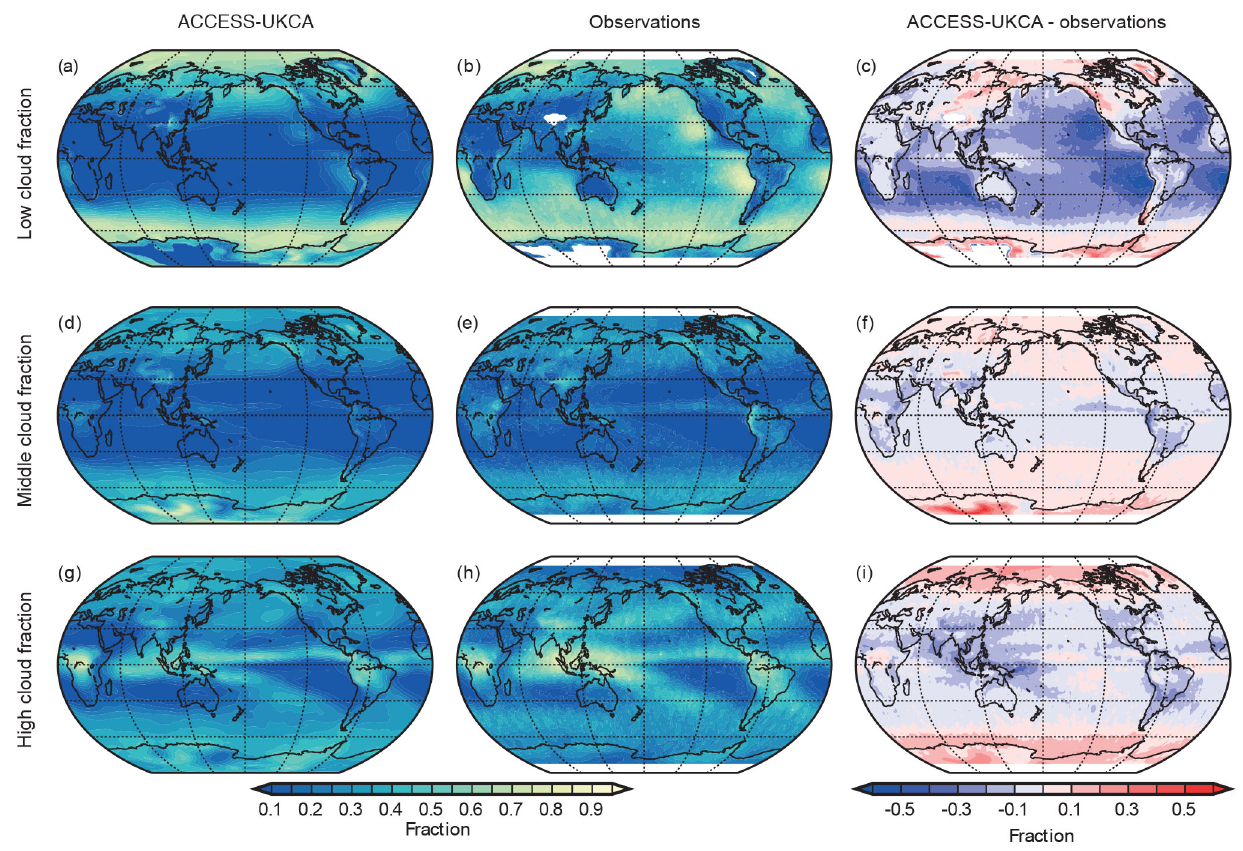
Figure 3. The 2006–2009 annual mean of the ACCESS-UKCA Ctl (a, d, g) compared to the CALIPSO-GOCCP (Chepfer et al., 2010) climatology (b, e, h) , with the relative differences between the two shown in (c) , (f) and (i) (model – observations). Panels (a) , (b) and (c) show the low cloud fraction, (d) , (e) and (f) show the middle cloud fraction and (g) , (h) and (i) show the high cloud